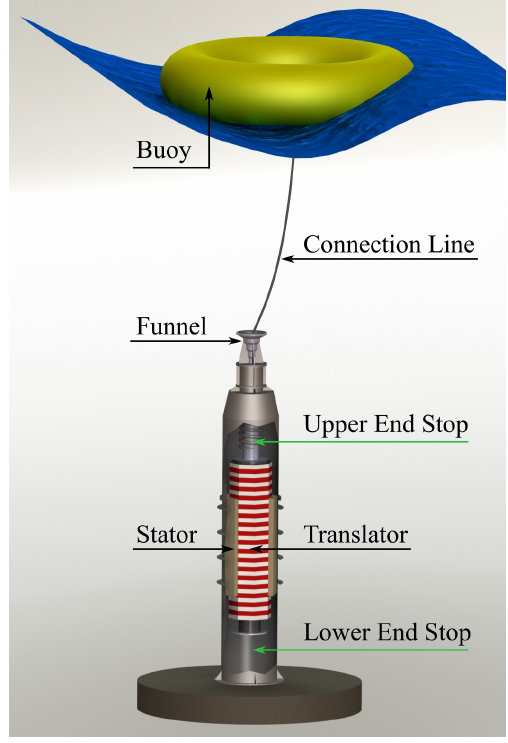
Figure 1. Illustration of the point absorber WEC developed at Uppsala University. Reprinted from Castellucci et al.